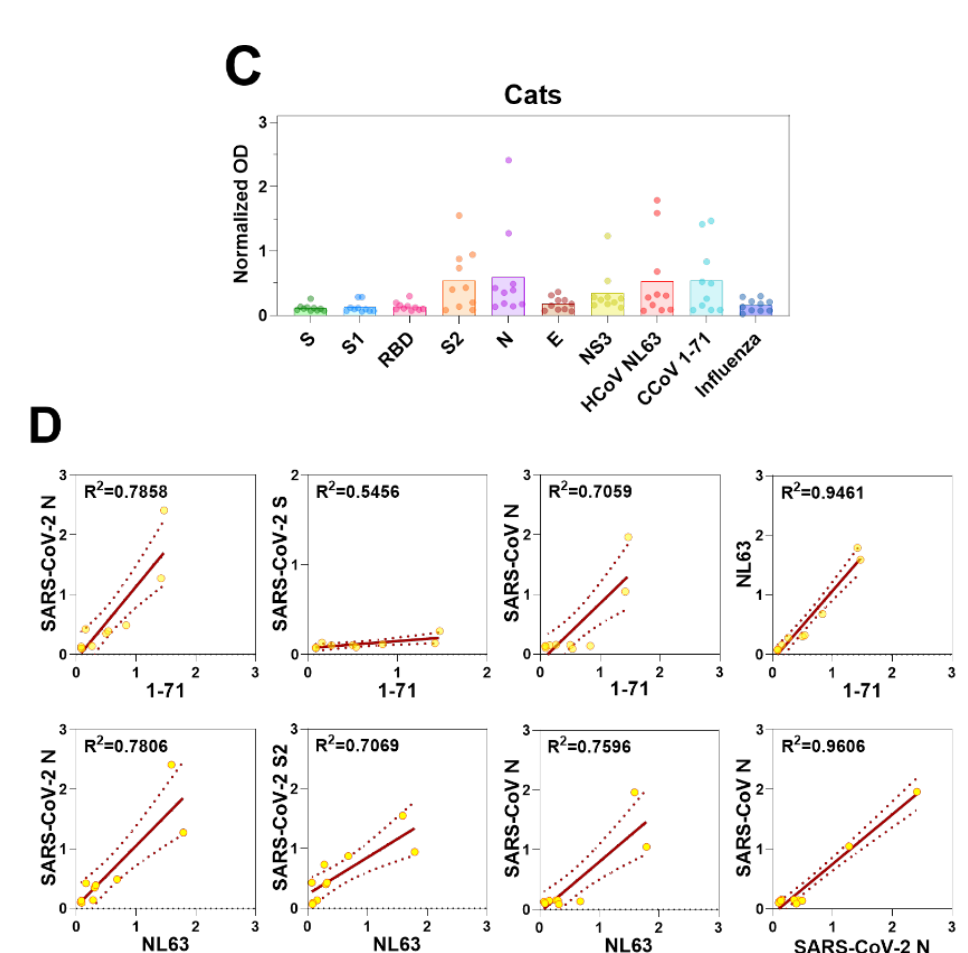
Figure 4. Antibody responses in dogs and cats. ( A ) Serum antibody responses of dogs to S, S1, RBD, S2, N, E, and NS3 viral proteins of SARS-CoV-2, and inactivated viruses, CCoV 1-71, HCoV NL63, and H1N1 influenza virus were measured by IgG ELISA. The OD values were normalized by subtracting the OD values generated by sera from SPF dogs. ( B ) In canine serum samples, IgG levels against CCoV / HCoV and those against S, S1, RBD, S2, N, E, and NS3 of SARS-CoV-2, as detected by ELISA, were used in correlation analyses. ( C ) Serum IgG antibody responses of cats to SARS-CoV-2 S, S1, RBD, S2, N, E, and NS3, and and inactivated viruses, CCoV 1-71, HCoV NL63, and H1N1 influenza virus were measured by ELISA. The crude OD values generated by ELISA were normalized by subtracting the OD values generated by sera from SPF cats. ( D ) ELISA was also used to determine IgG antibody levels against N of SARS-CoV-2, CCoV 1-71, and HCoV NL63 in the sera of cats for correlation analyses.